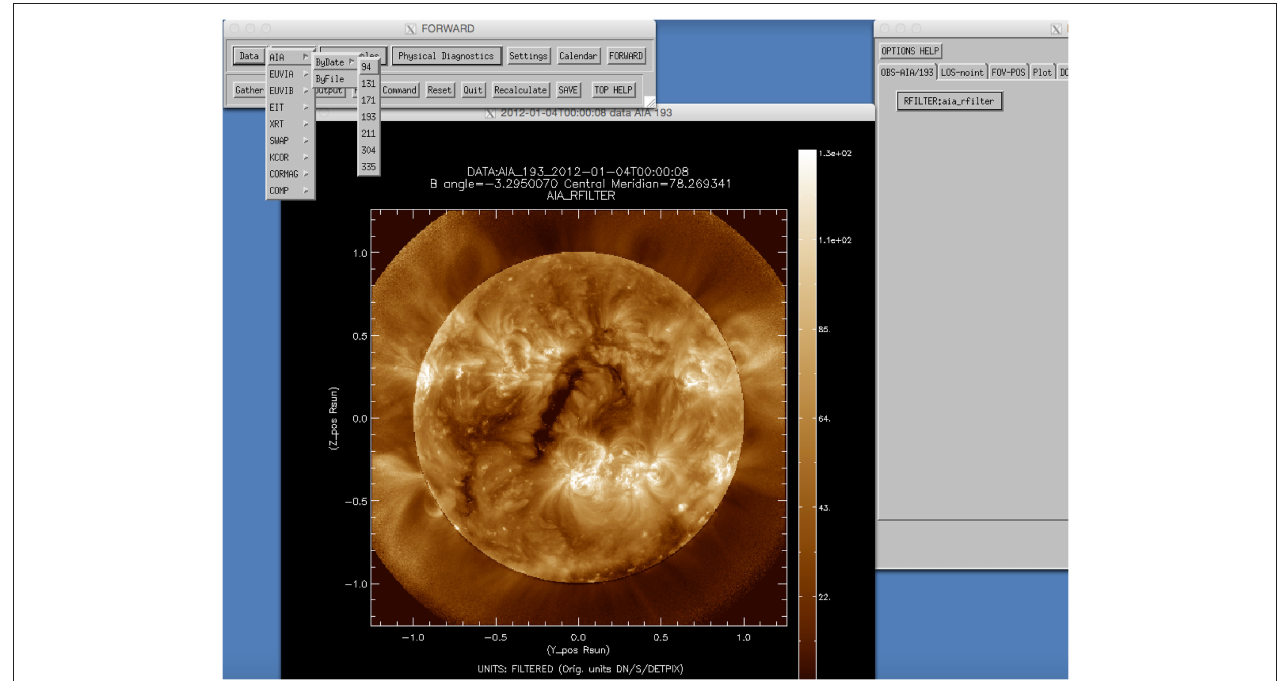
FIGURE 9 | Example of automatically uploading SDO/AIA data via FORWARD widget by date access. Data are accessed via either the Virtual Solar Observatory SolarSoft interface, or an observatory’s own web interface. Data may also be uploaded by file from locally stored FITS files, and in some cases (e.g., the CorMag telescope—Fineschi et al., in preparation), this is currently the only available choice.